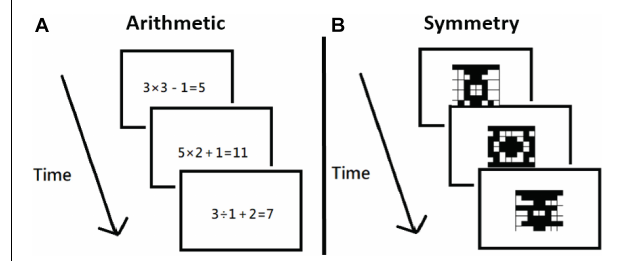
FIGURE 3 | Procedures of the secondary tasks. The participants had to judge correct vs. incorrect within 3,500 ms for the arithmetic task (A) , and judge symmetrical vs. asymmetrical within 1,000 ms in the symmetry task (B) . These tasks were modified based on what was a working memory task by Foster et al.